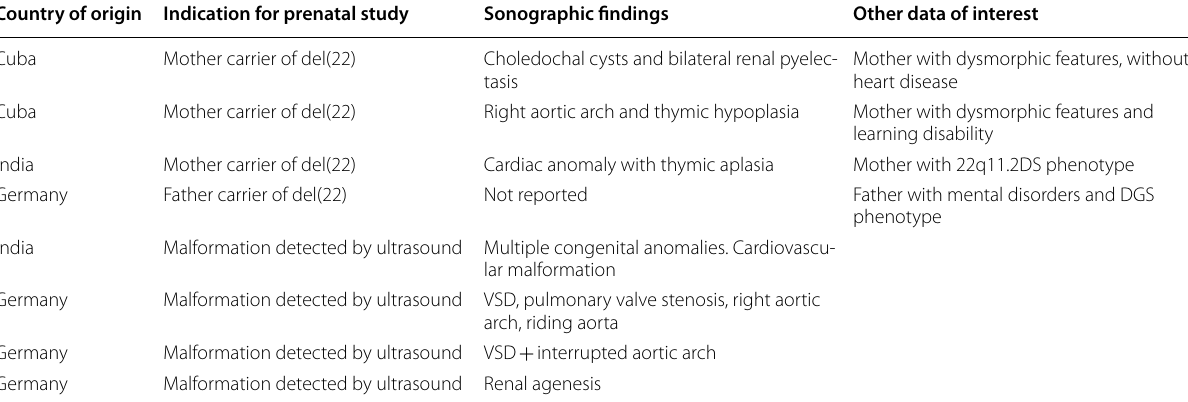
VSD ventricular septal defect